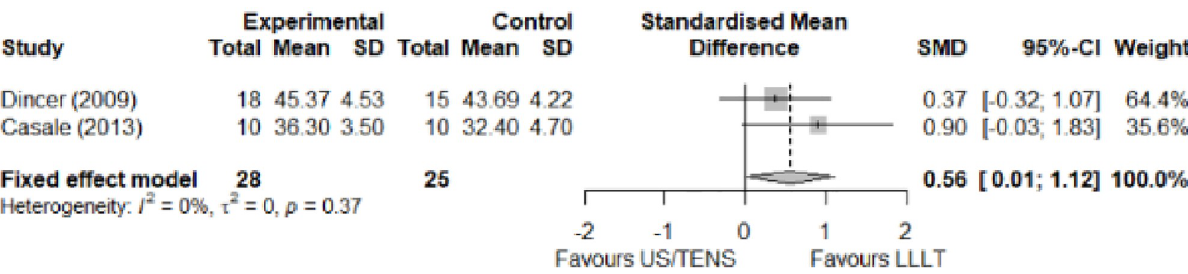
Fig 25. Analysis—Comparison between electrophysical modalities (sensory velocity).